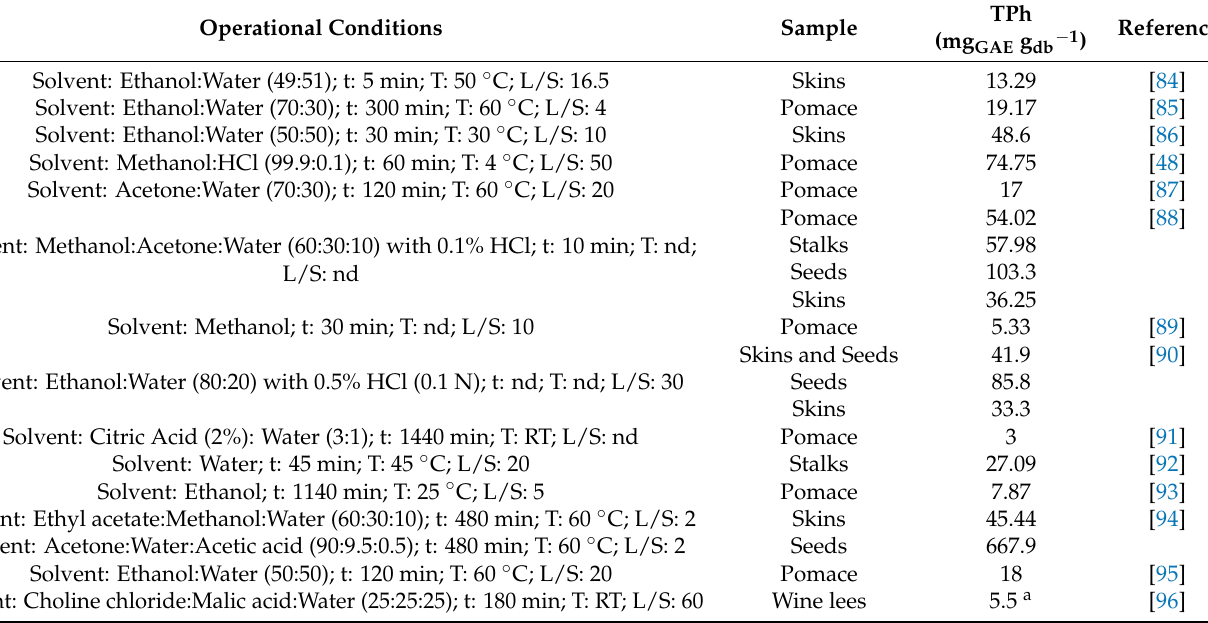
Table 6. Summary of solid–liquid extraction for the recovery of phenolic compounds from solid winery